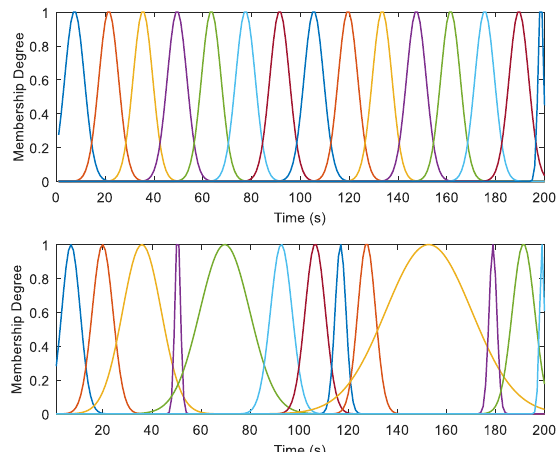
Figure 6. Fuzzy granules relevant membership functions: at first (above) and after update (below).